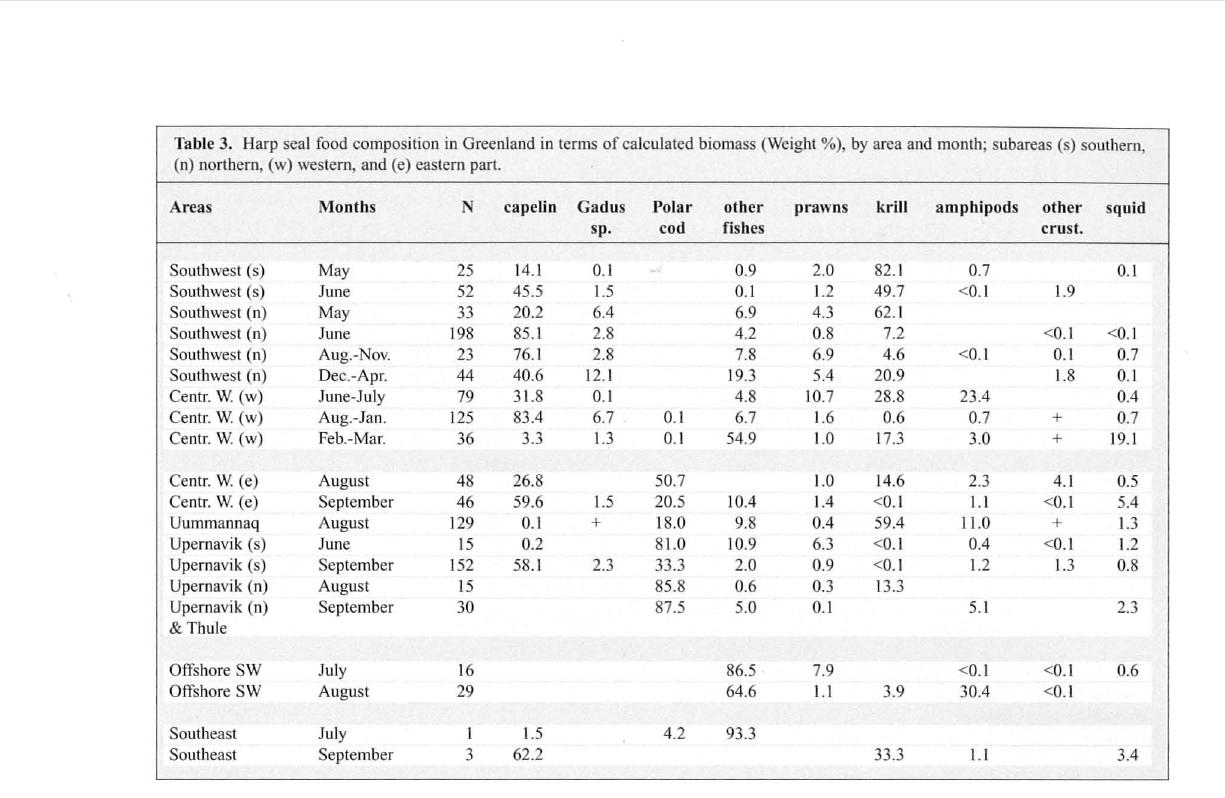
Table 3. Harp seal food composition in Greenland in terms of calculated biomass (Weight %), by area and month; subareas (s) southern, (n) northern, (w) western, and (e) eastern part. Areas Months N capelin Gadus